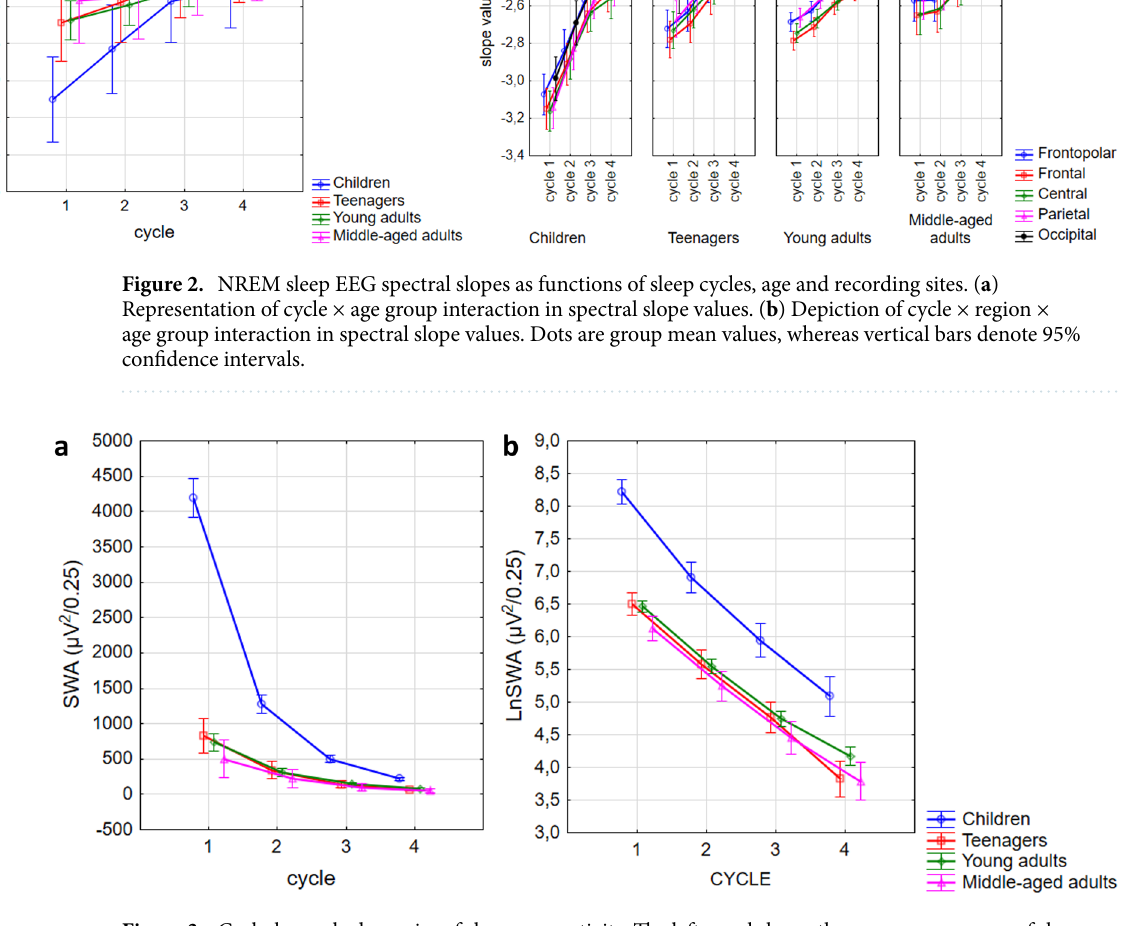
Figure 3. Cycle-by-cycle dynamics of slow wave activity. The left panel shows the common measure of slow wave activity in different age groups and sleep cycles. The natural logarithm of SWA is depicted in the right panel. Note that the decrement of lnSWA is nearly